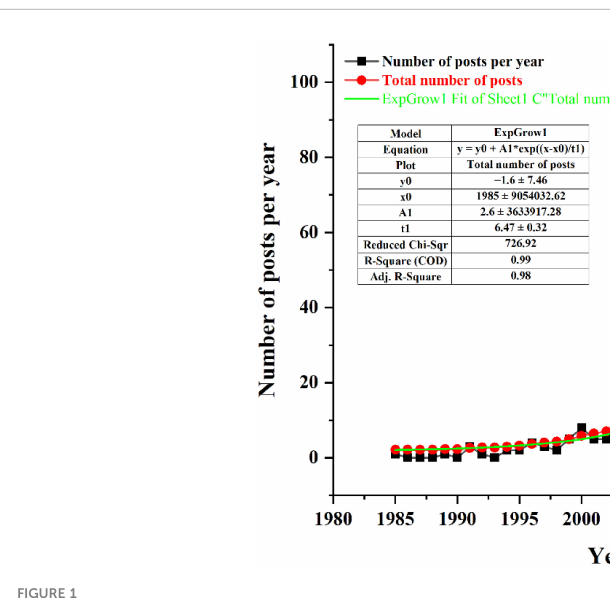
FIGURE 1 Annual publications covering research on acupuncture for cancer pain.